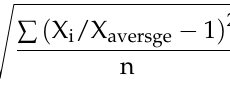
Figure 4. Setup for single fiber pullout test. 2.5. Microstructure Characterization Test To characterize the influence of LC 3 binder system on the micropore structure of ECC matrix, MIP was used to determine the porosity and pore size distribution curves of the matrix. Poromaster GT-60 Mercury Intrusion Porosimeter, Quantachromre (Boynton Beach, FL, USA), was used for MIP testing. The small sample particles were immersed in absolute ethyl alcohol to terminate hydration and then vacuum oven-dried at 60 ℃ for 24 h before test. The hydration phases of the cementitious matrix were investigated by car- rying out XRD test. D8 ADVANCE X-Ray Diffractometer, BRUKER, AXS (Karlsruhe, Ger- many), was used for XRD testing. Samples were vacuum dried and then grounded into fine powders. Cu K α radiation ( λ = 1.54 Å) was performed at 40 kV and 40 mA, and the scan speed was set to be 0.02°/step. The TGA test was also conducted to study the phase assemblage of ECC matrix. STA409PC Simultaneous Thermal Analyzer, Netzsch (Nedgex